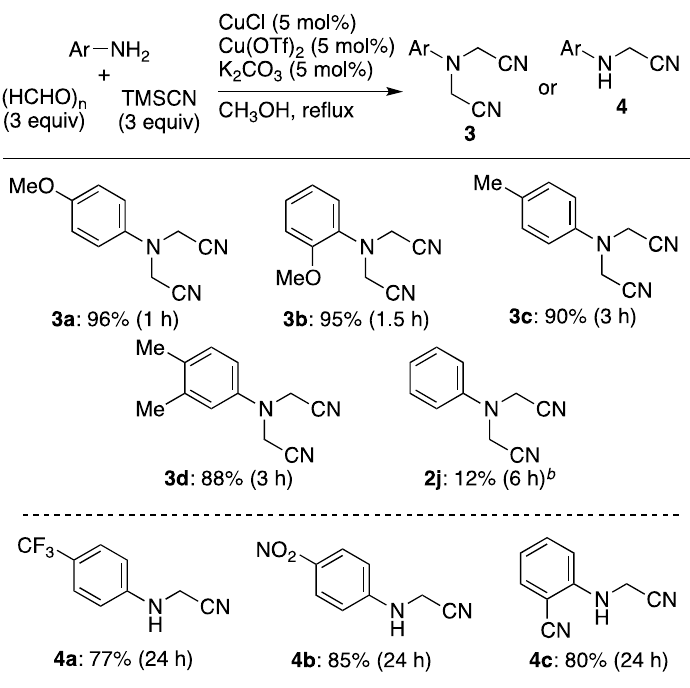
Table 4. Selective synthesis of bis(cyanomethyl)amines 3 and cyanomethylamines 4 with aromatic amines a